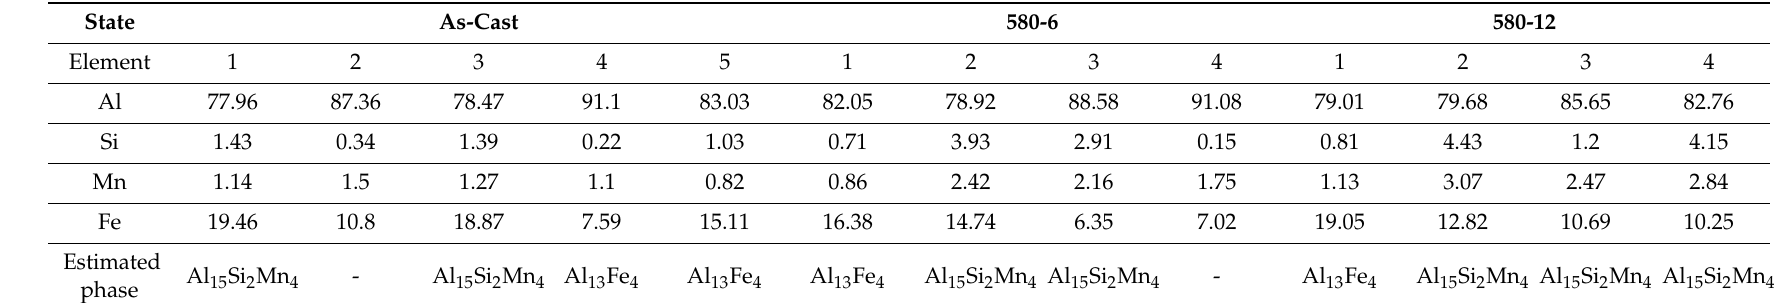
Table 3. EDS results showing di ff erent phases present in the investigated samples from Figure 7 in at. %.